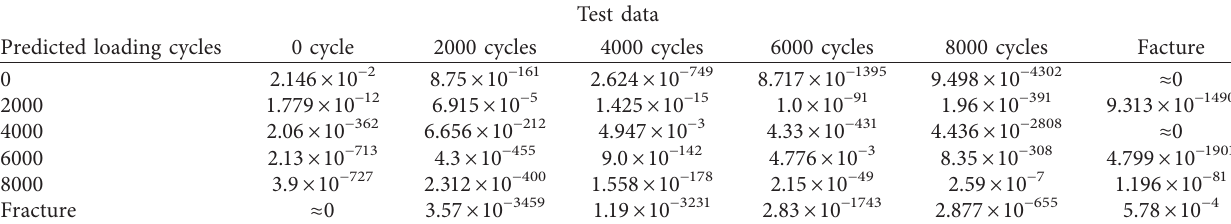
Table 3: Posterior probability values of test